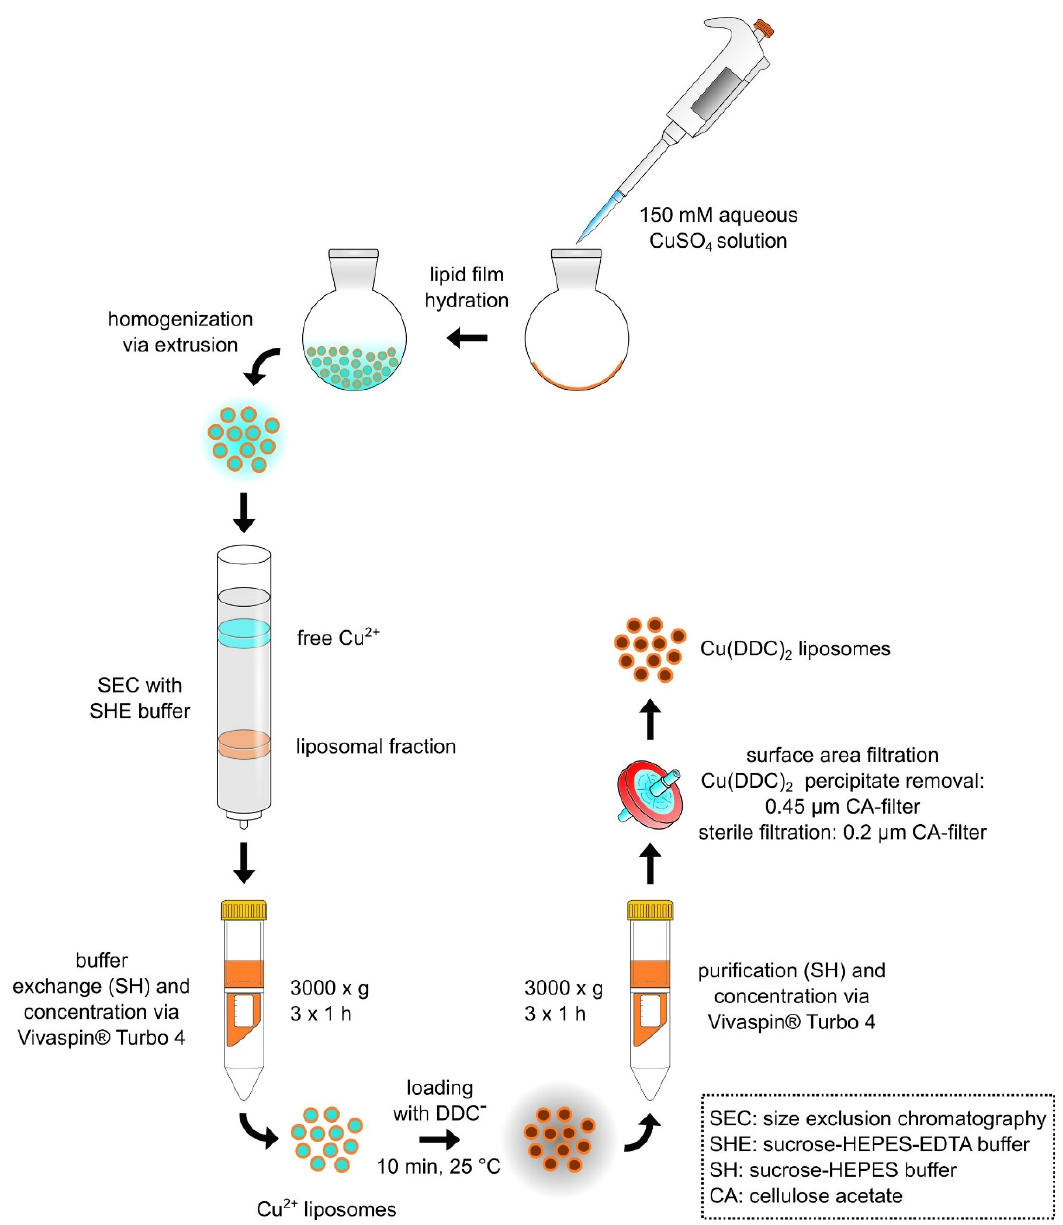
Figure 1. Schematic representation of Cu(DDC) 2 liposome preparation by generating Cu 2+ liposomes followed by remote loading of DDC - . This method was modified from Wehbe et al. (2016) [8].